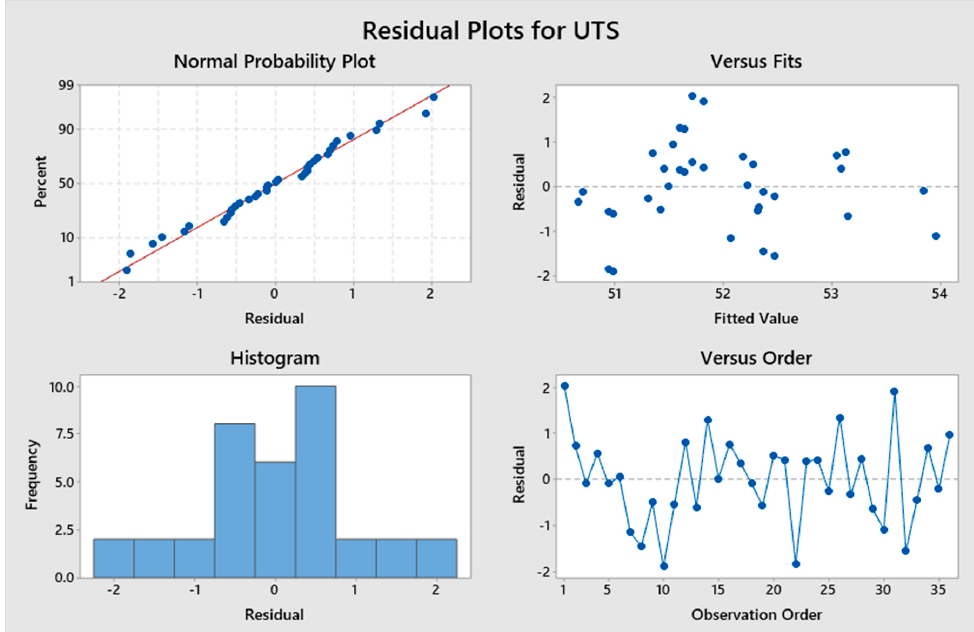
Figure 15. Residual plots for UTS through the two-way ANOVA method.